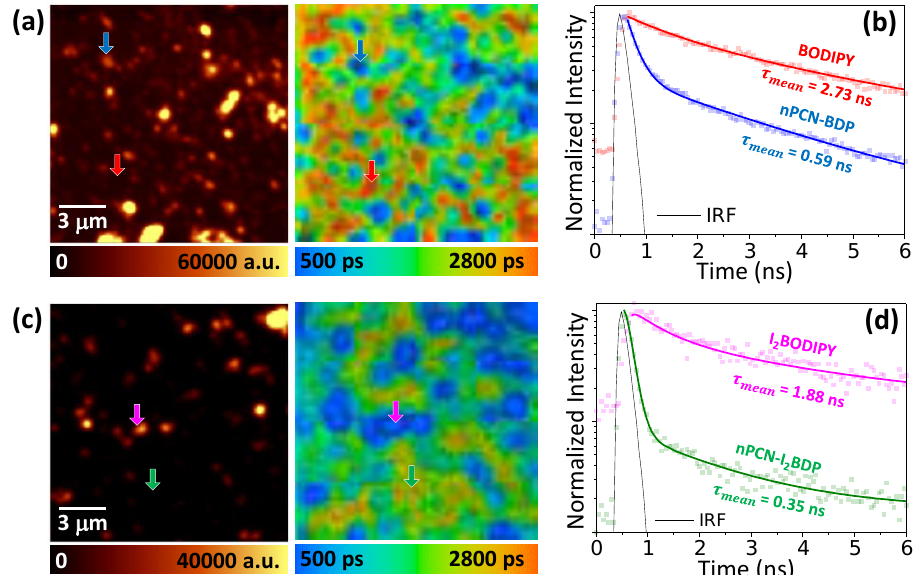
Figure 6. ( a ) Fluorescence intensity and lifetime maps of nPCN-BDP. ( b ) Representative fluorescence decay curves of donor emission of BODIPY monomer (red curve) and nPCN-BDP (blue curve). ( c ) Fluorescence intensity and lifetime maps of nPCN-I 2 BDP. ( d ) Representative decay curves of donor emission of I 2 BODIPY monomer (magenta curve) and nPCN-I 2 BDP (green curve). Instrument response function (IRF) is indicated by black line. Fluorescence lifetime maps were obtained from donor emission portion of nPCN-BDP (500–560 nm) and nPCN-I 2 BDP (530–590 nm). Energy transfer in nPCN-BDP system was also evinced by modified fluorescence lifetime of the acceptor. Figure 7 presents the spatial map of the mean fluorescence lifetime of nPCN-222, nPCN- BDP and nPCN-I 2 BDP at acceptor emission between 630 nm and 750 nm and representative time decay curves of fluorescence.